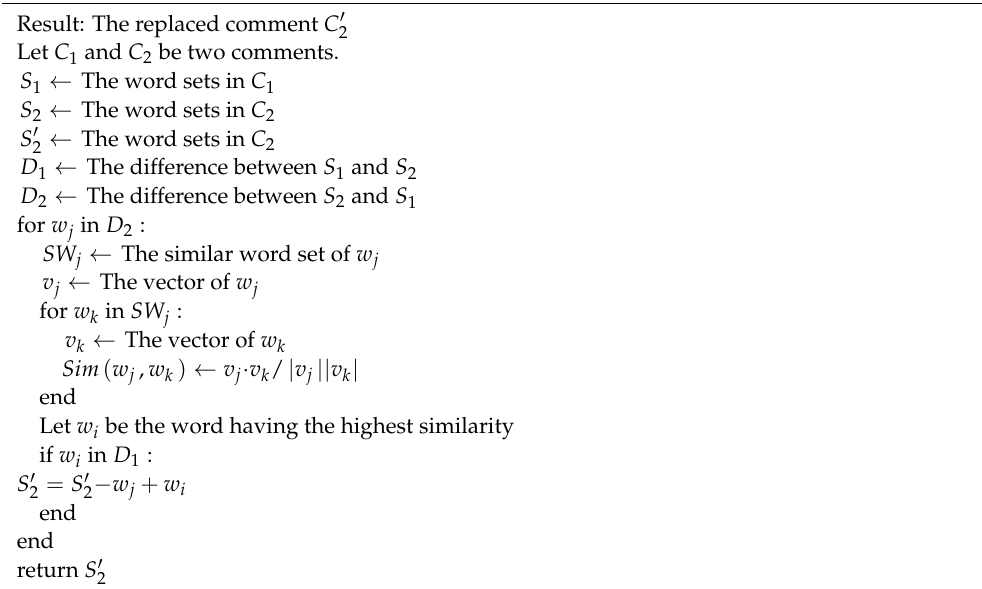
Algorithm 1. Similar Word Replacement using